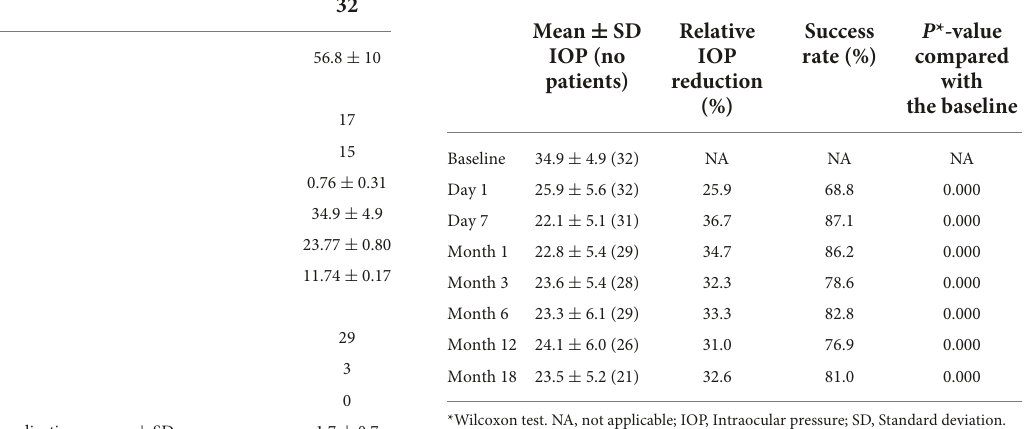
TABLE 1 Patients characteristics. TABLE 2 Intraocular pressure at baseline and during follow-up in the